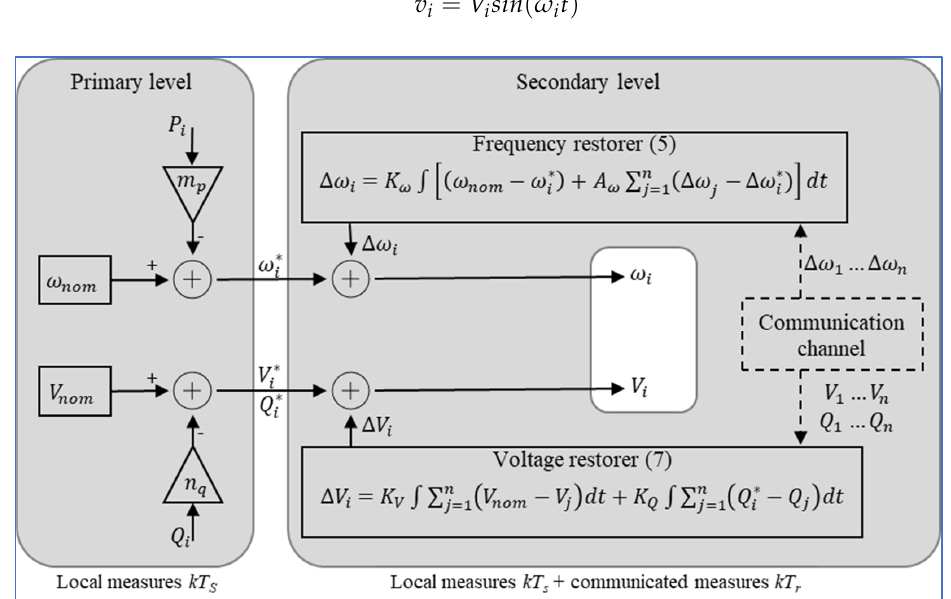
Figure 2. Primary and secondary controllers in each microgrid node, based on